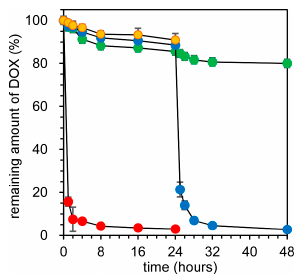
Figure 2. Release profiles of DOX from disulfide (SS)-bonded and X-linked nanocapsules at the extracellular GSH concentration (first 24 h incubation period, 10 μ M) and the intracellular GSH concentration (second 24 h incubation period, 0.5 mM). Free DOX at pH 7.4, ● ; DOX in SS-bonded nanocapsules at pH 7.4, ● . The data are the average of three experiments ± SD.